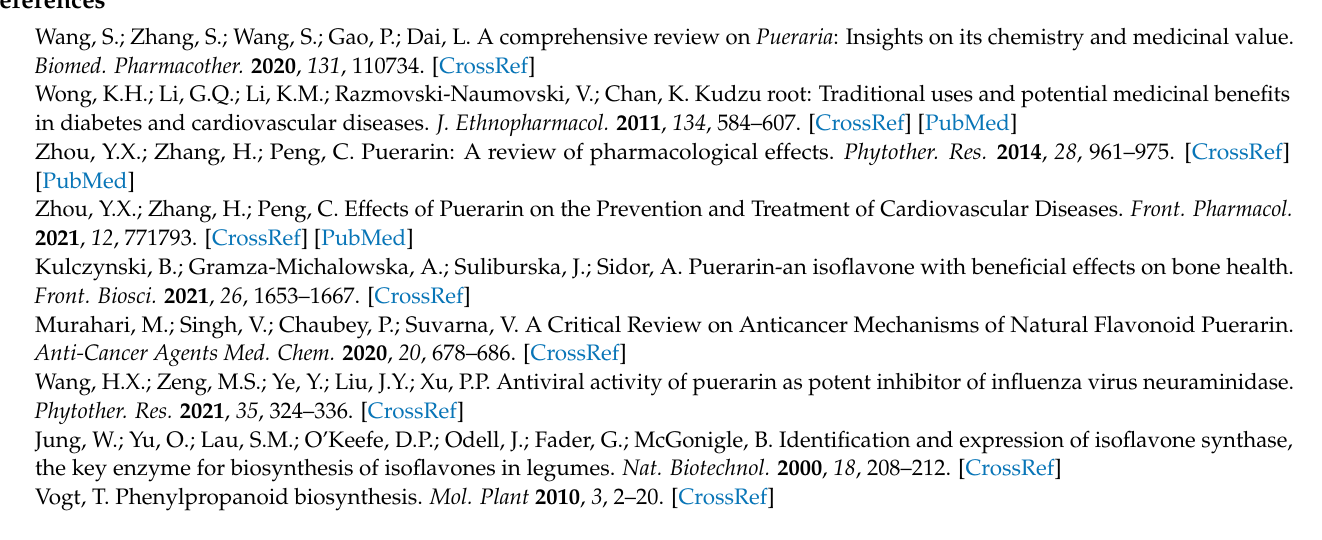
Table S2: Summary statistics of the mapping of RNA-sequencing reads derived from each sample of this study to the genome of P. lobata var. thomsonii; Table S3: Summary statistics of functional annotations for unigenes and transcripts of P. lobata via public databases; Table S4: Transcript abundances of upstream genes for the biosynthesis of isoflavones in each P. lobata sample; Table S5: Accession number of the previously characterized C- and O-UGTs selected for the phylogenetic analysis in this study; Table S6: Predicted amino acid sequences of the three PlUGT candidates in this study; Table S7: Predicted amino acid sequences of the three PlMYB candidates in this